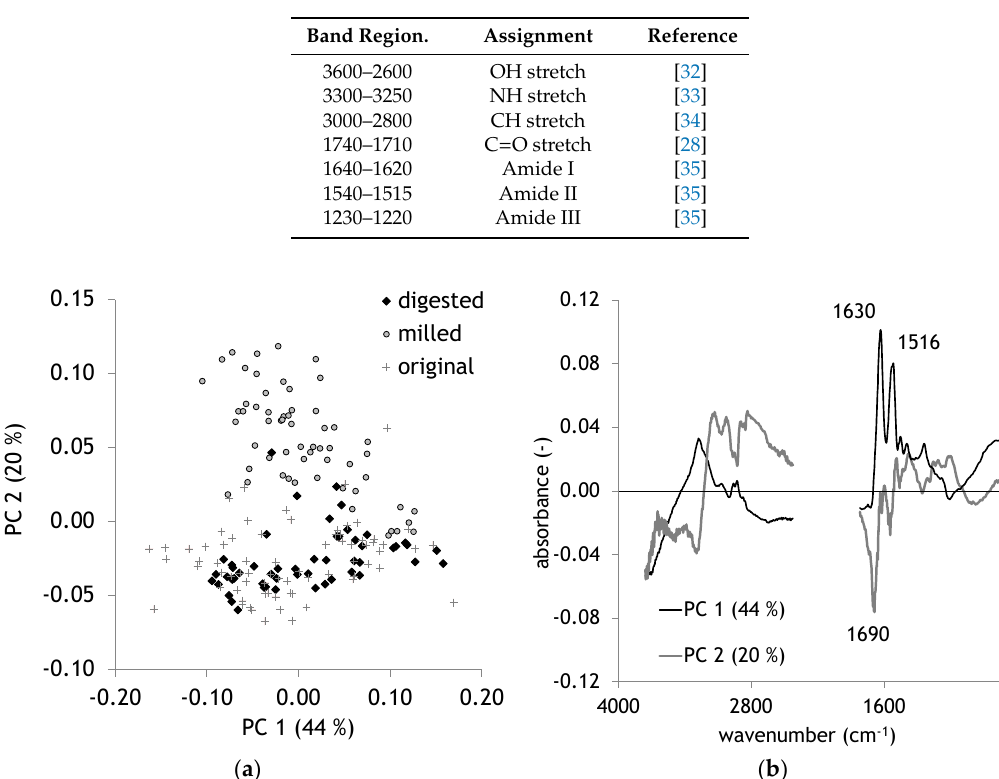
Figure 2. ( a ) Scores plot of Principal Component Analysis (PCA), ( b ) loadings plot, n = 183.